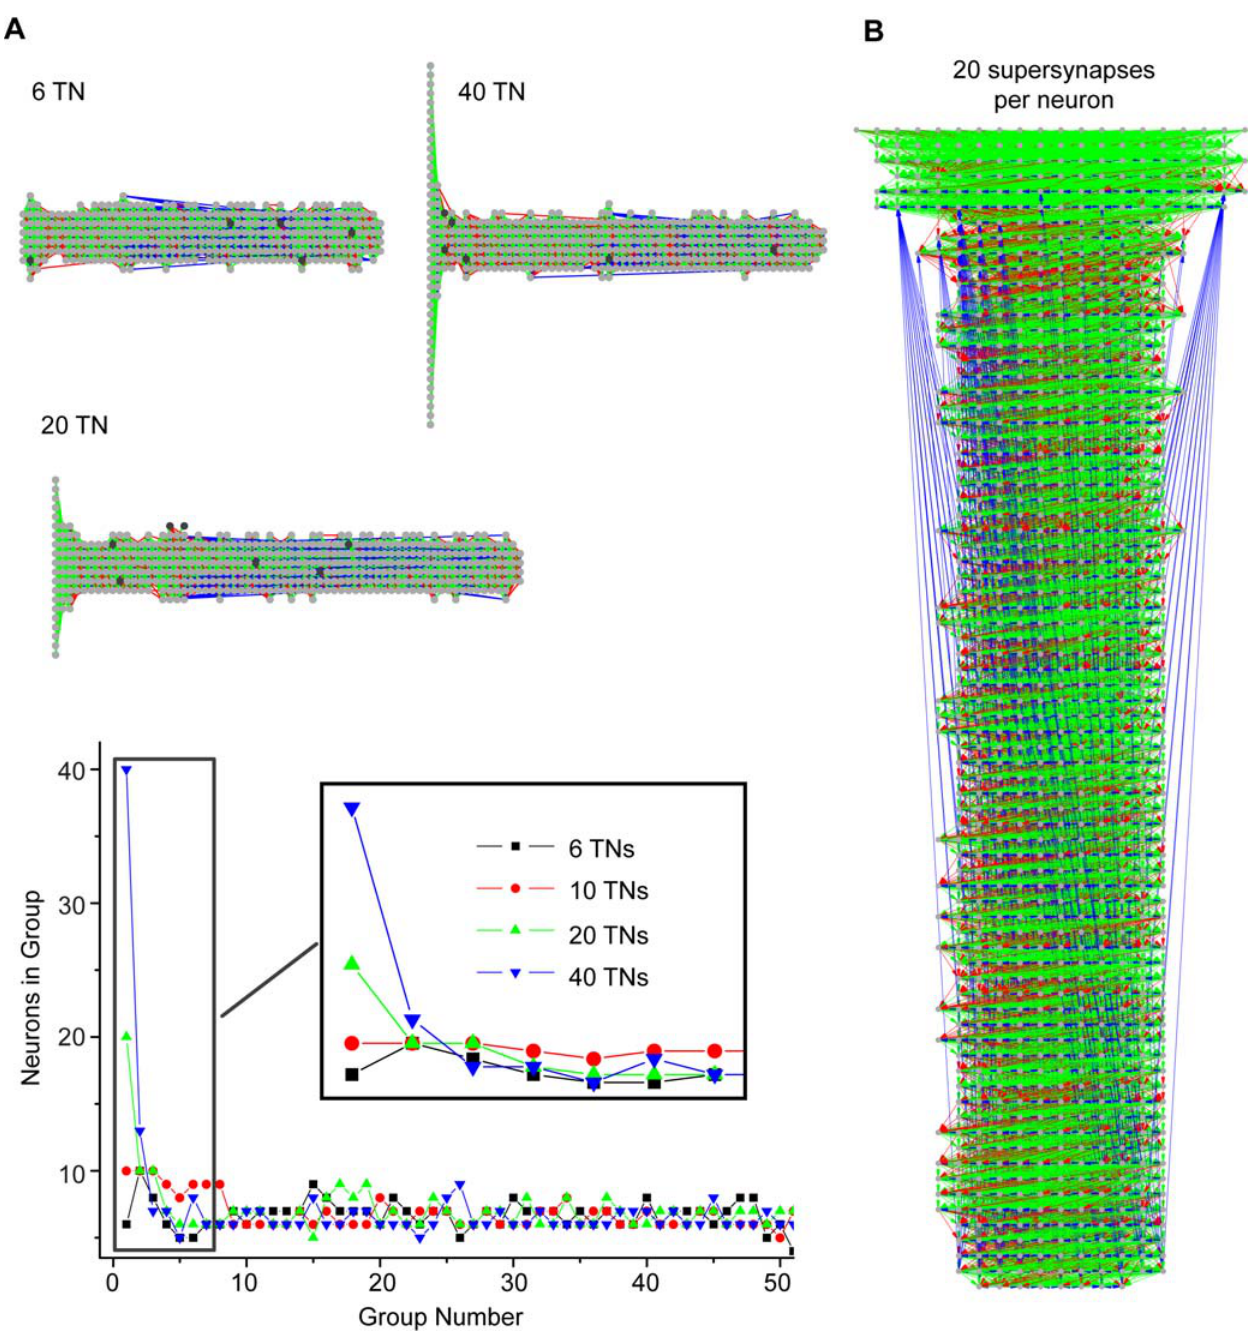
Figure 7. Simulations varying the number of training neurons and the number of supersynapses per neuron. (A) (Upper) Networks formed with three different numbers of training neurons (TN). After a few groups, the width of the synfire network returns to a steady state size. The color coding is identical to Figure 3. (Lower) The distribution of neurons in each group for four networks formed using different numbers of TN; line color and shape encode the different values of number of TN. The number of neurons per group quickly converges to the same number, independent of the number of TN. The inset shows the distribution for the first 7 groups. The curve with 10 TN is from Figure 3; the other three curves are from the networks above. (B) A network formed with the numbers of supersynapses and TN both set to 20; all other parameters were the same as in Figure 3. The major difference compared to the network shown in Figure 3 is that the number of neurons per group is higher. doi:10.1371/journal.pone.0000723.g007 network right after the ( , 20%) lesion. The lower network of We repeated the simulation using different levels of lesions Figure 10A shows the network recovery after 100000 training (Figure 10B). Different amounts of lesions lead to recovered trials. The final chain is both shorter (smaller in total number of networks of different sizes; in all cases, the chains were shortened groups) and wider (greater in number of neurons per group). Note (Figure 10B). The relative amount that the chains were shortened that the cycle from the pre-lesion chain persists after recovery. did not depend on the level of lesions to a point (Figure 10C). For